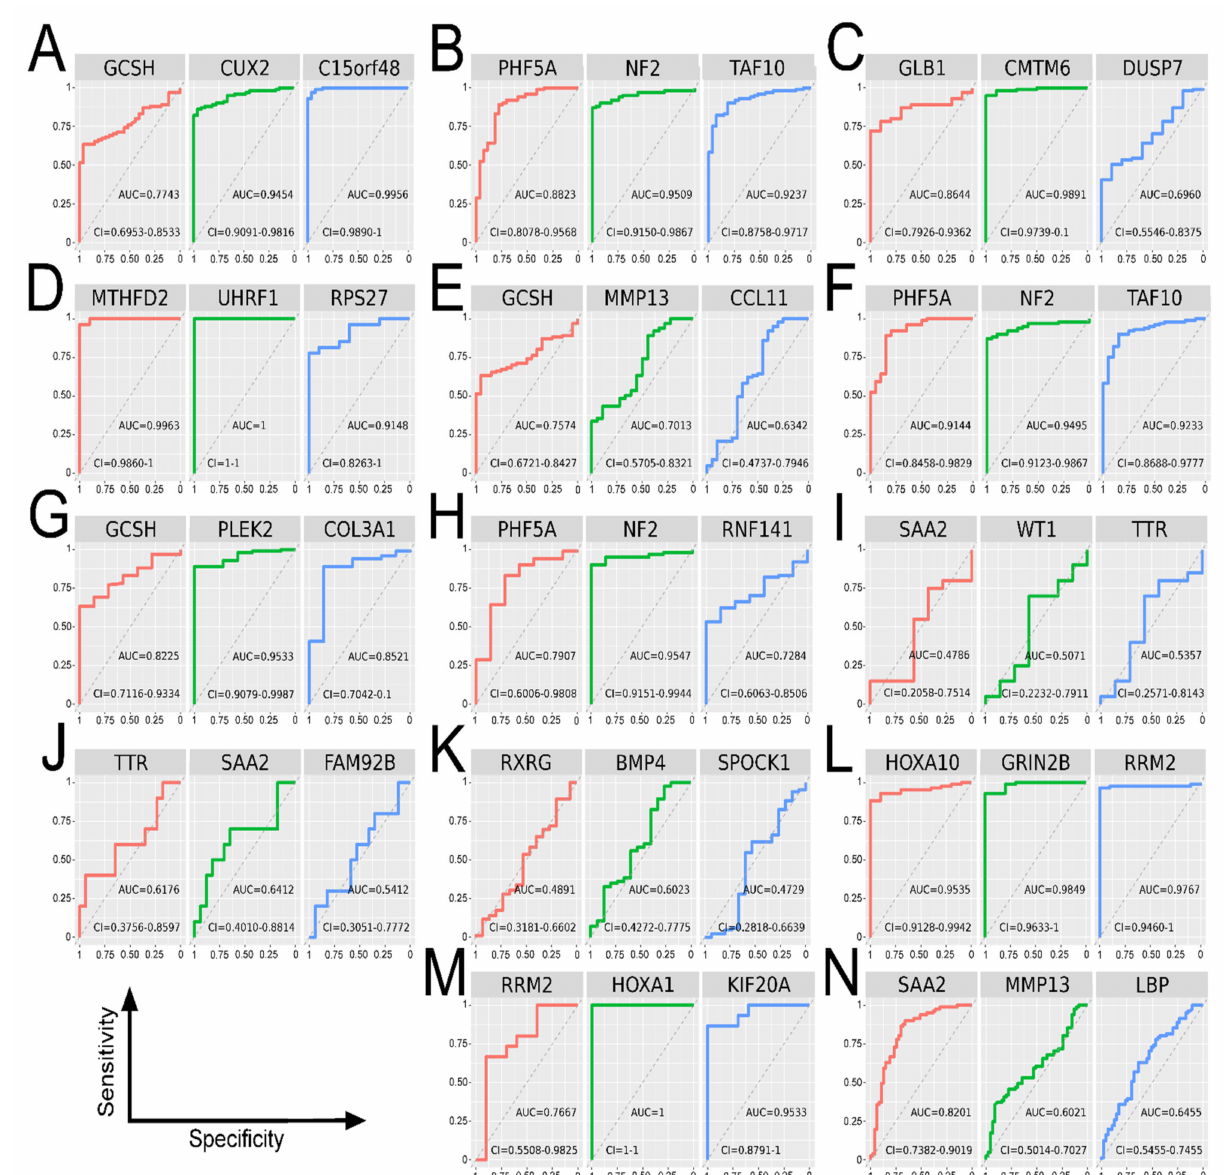
Figure 6. ROC analysis of top genes from comparisons—validation of the results using Agilent 244K G4502A microarray data. ( A ) GBM vs. LGG, set 1 + 3 + 6. ( B ) GBM vs. LGG, set 2 + 4 + 5 + 7. ( C ) GBM vs. NT, set 5 + 6. ( D ) LGG vs. NT set 1. ( E ) G4 vs. G3, set 1 + 3 + 6. ( F ) G4 vs. G3, set 2 + 4 + 5 + 7. ( G ) G4 vs. G2, set 1 + 3 + 6. ( H ) G4 vs. G2, set 2 + 4 + 5 + 7. ( I ) G3 vs. G2, set 1 + 3 + 6. ( J ) A vs. OA and OD, set 1 + 5 + 7. ( K ) Untr GBM vs. Tr, set 1 + 4 + 5 + 6. ( L ) Untr GBM vs. NT, set 1 + 4 + 5 + 6. ( M ) Tr vs. NT, set 1 + 4 + 5 + 6. ( N ) >45 vs. ≤ 45, set 1 +